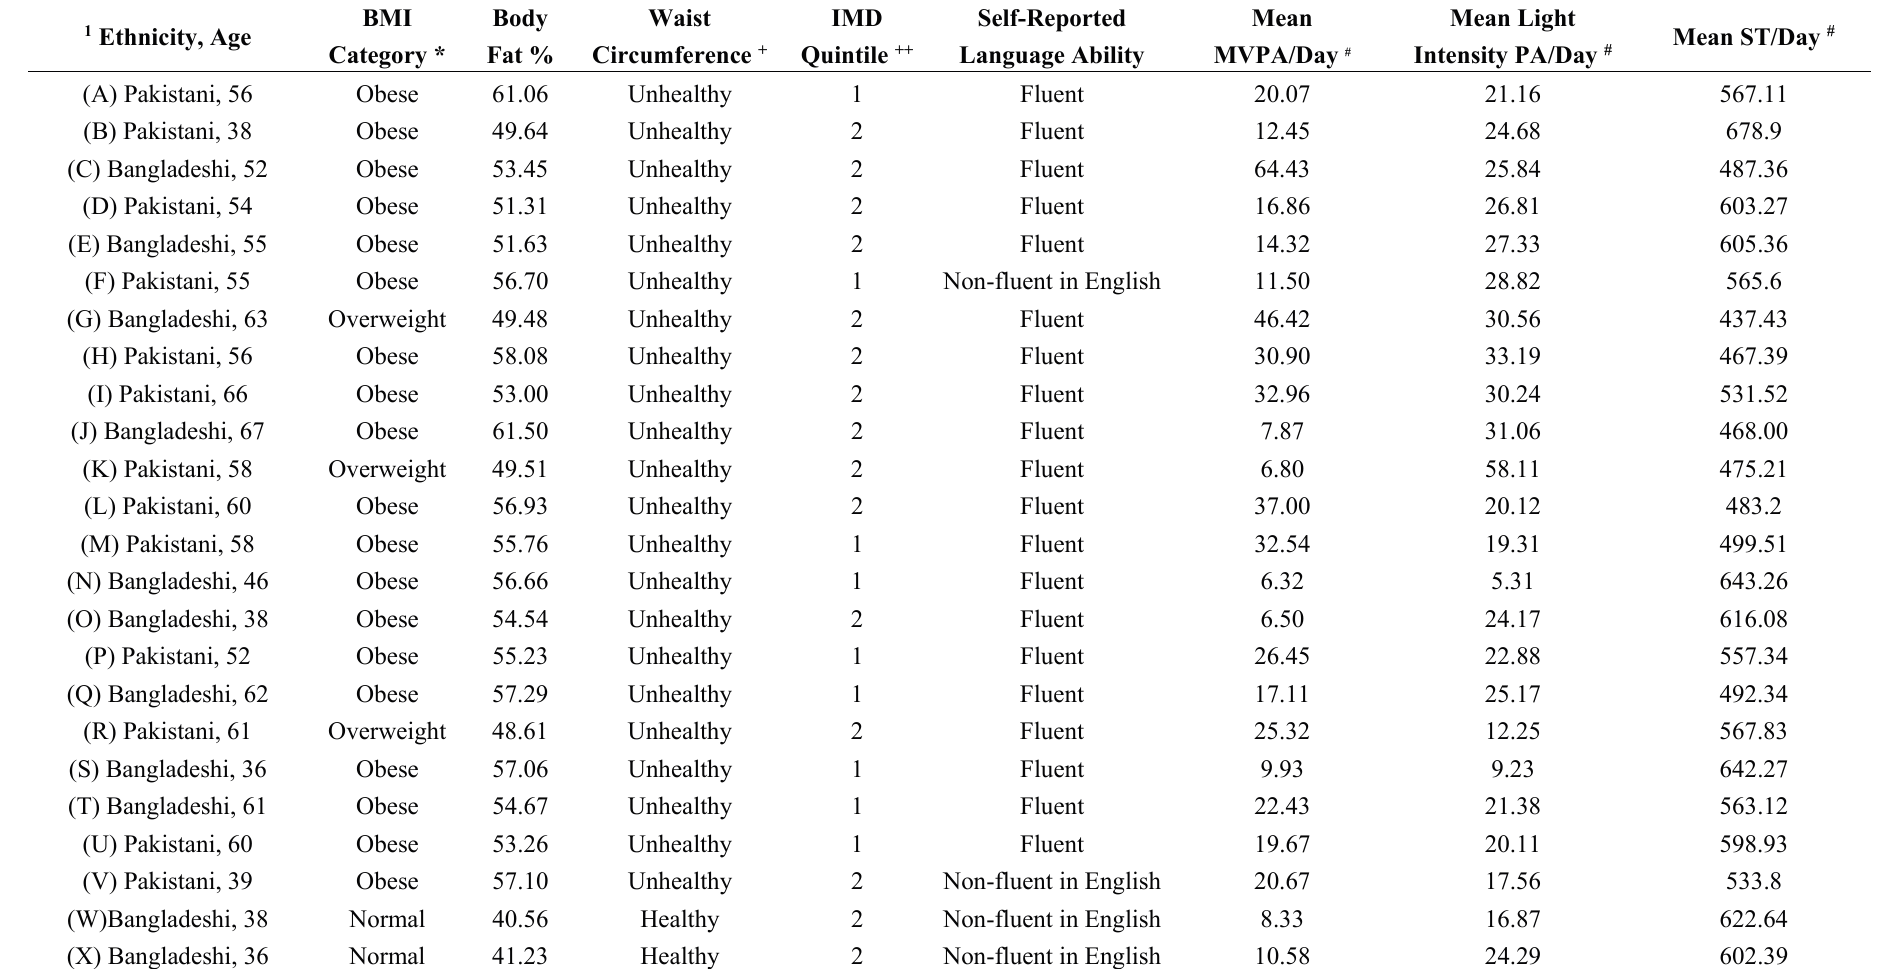
Table 1. Sample characteristics of the 24 South Asian women participating in semi-structured